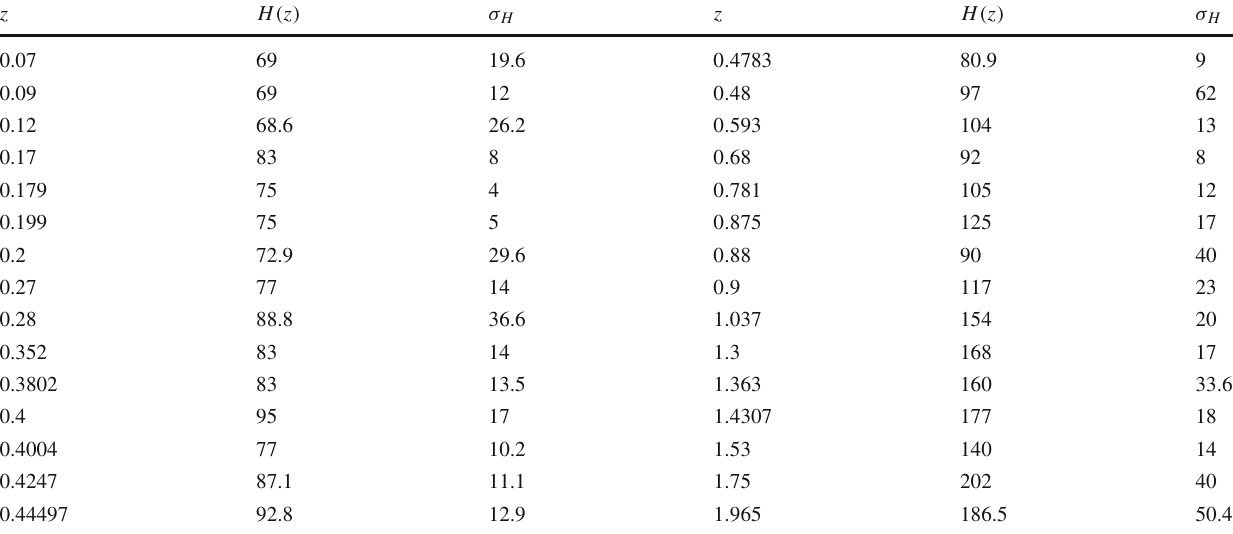
Table 1 The observational data for H = H ( z ) and their uncertainty σ H in units of km/s/Mpc. The 30 data points were obtained from the differential age method of cosmic chronometers. This table is taken from [107] (see references therein for comments about each data point)